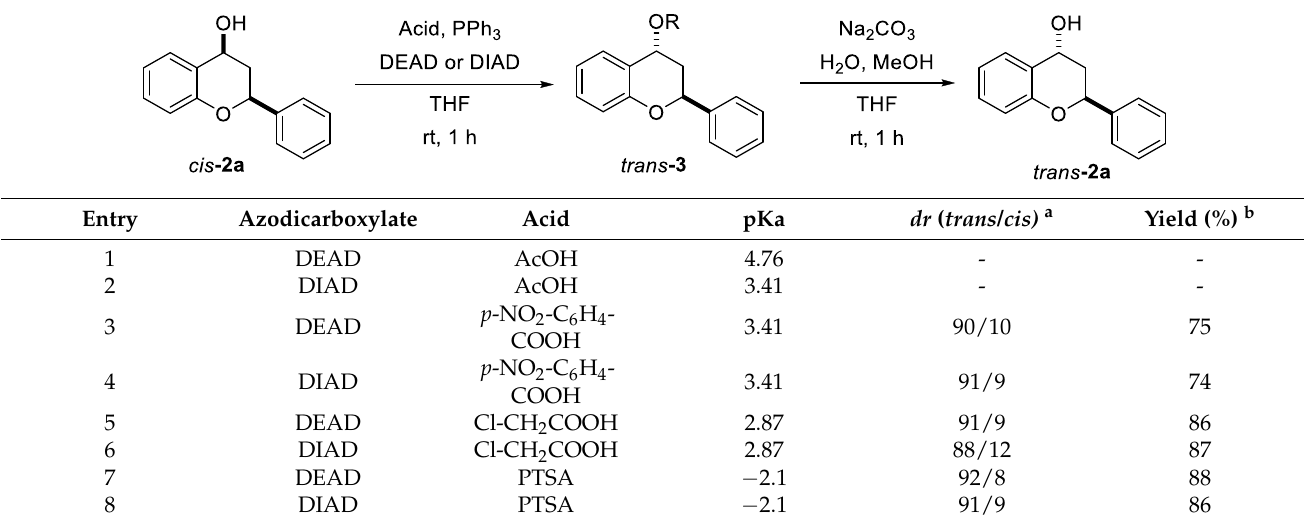
Table 1. Investigation of the optimal conditions for the Mitsunobu protocol for the C-4 configuration inversion of racemic cis - 2a to produce the corresponding trans - 2a .